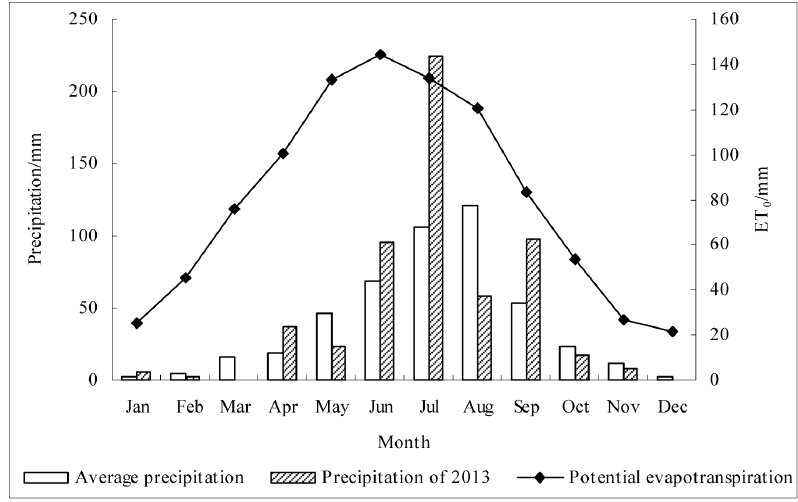
Figure 2. Average annual precipitation and potential evapotranspiration of 1967–1999 and precipitation in 2013 in the Sanyanjing catchment, Shanxi province, China.